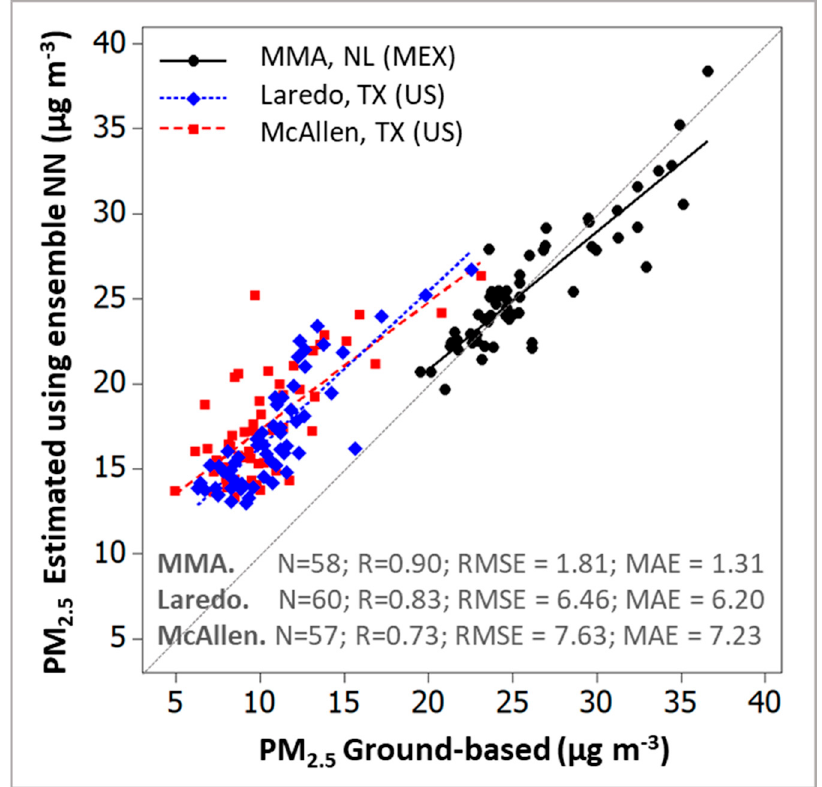
Figure 11. Comparison of the statistical performance obtained using the ENN to estimate monthly PM 2.5 means over the MMA, Laredo, and McAllen sites from January 2010 to December 2014.